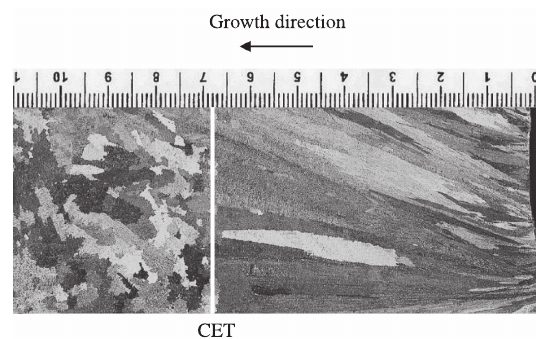
Figure 5. Solidification macrostructure and the corresponding CET position